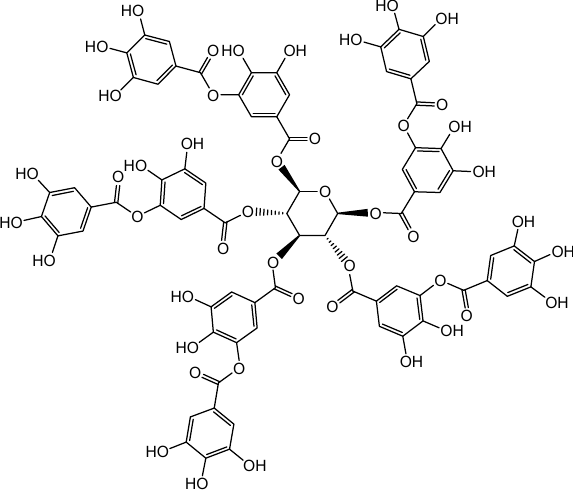
Figure 1. Chemical structure of tannic acid.